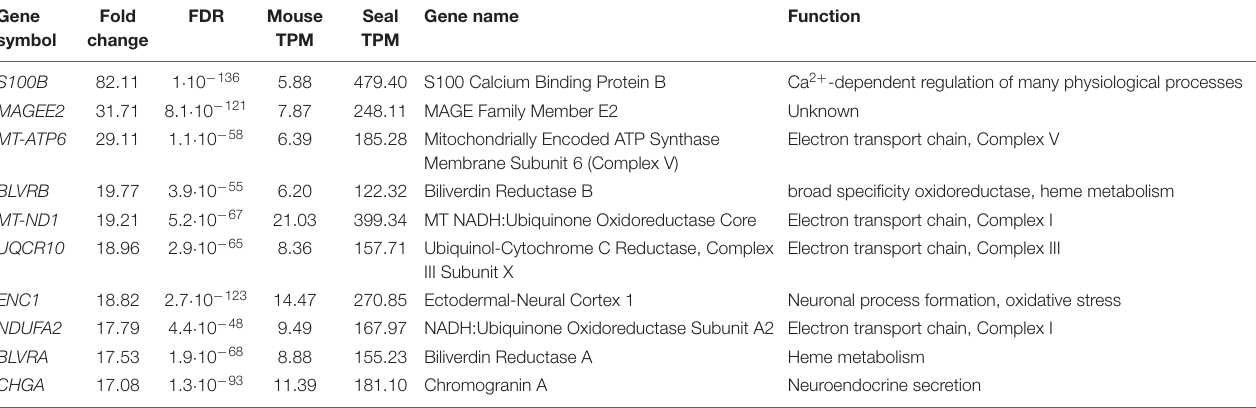
TABLE 1 | Top 10 differentially expressed genes: genes with the highest fold change in the neurons of the hooded seal visual cortex compared to the mouse. Gene Fold symbol change